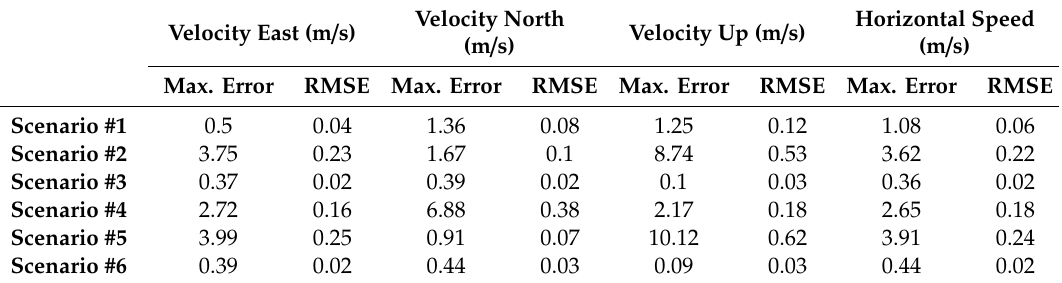
Table 10. Velocity error for all